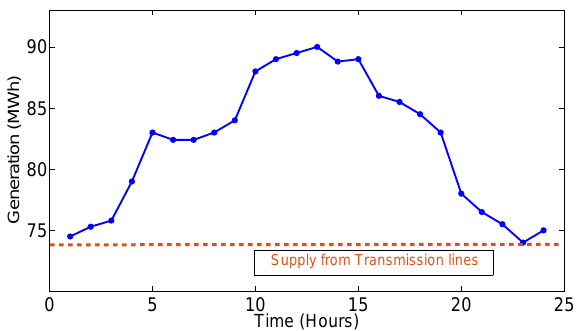
Figure 6. Renewable energy generation and supply from bulk utility supply data.